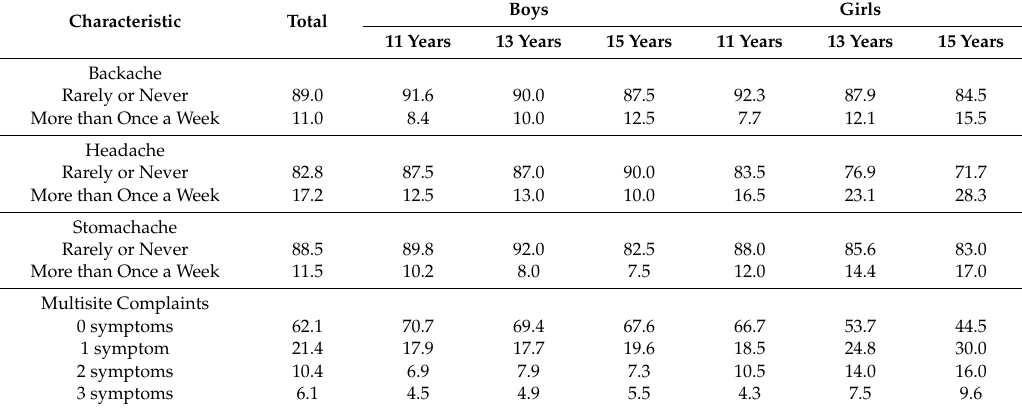
Table 2. Prevalence of subjective health complaints by age and gender (in